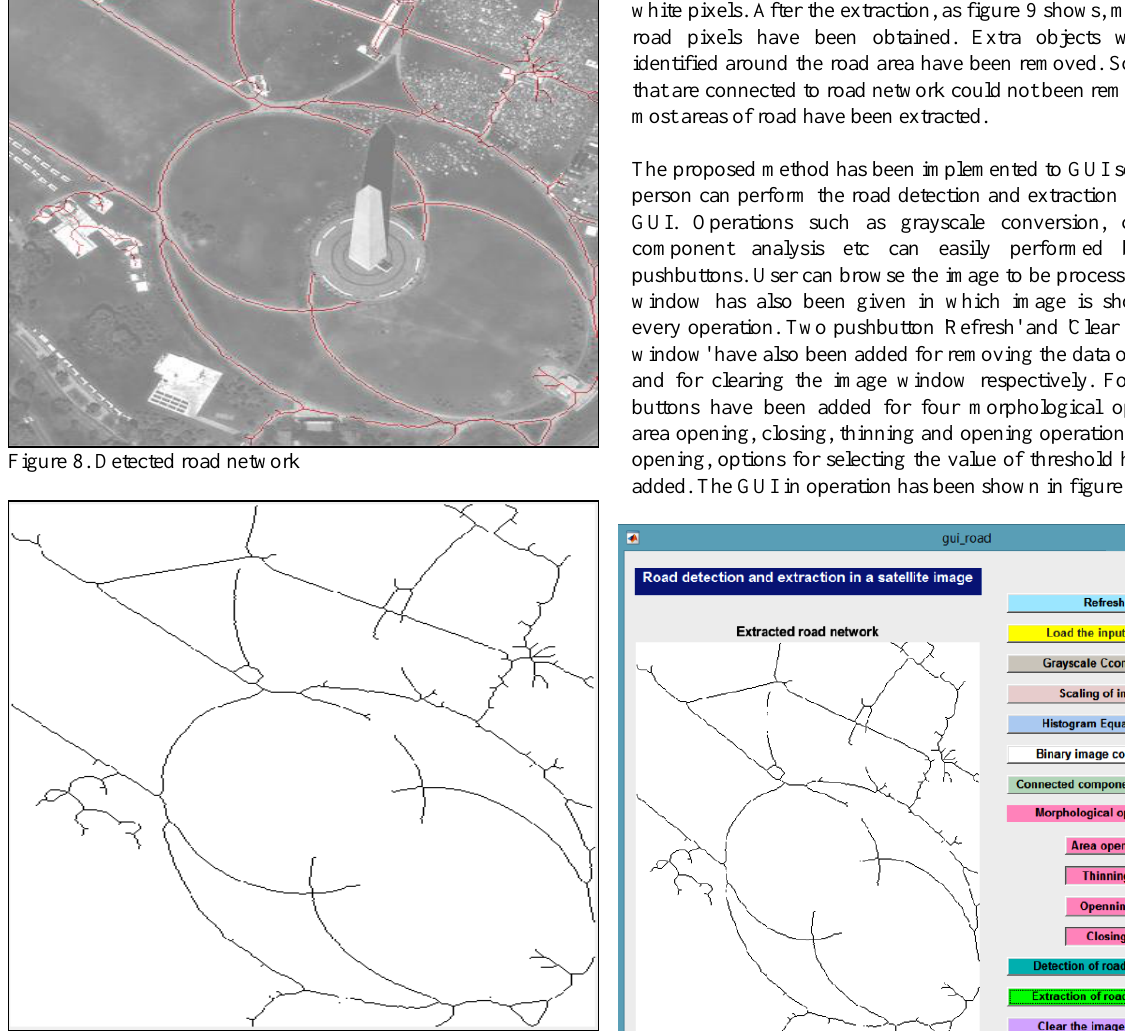
Figure 9. Extracted road network